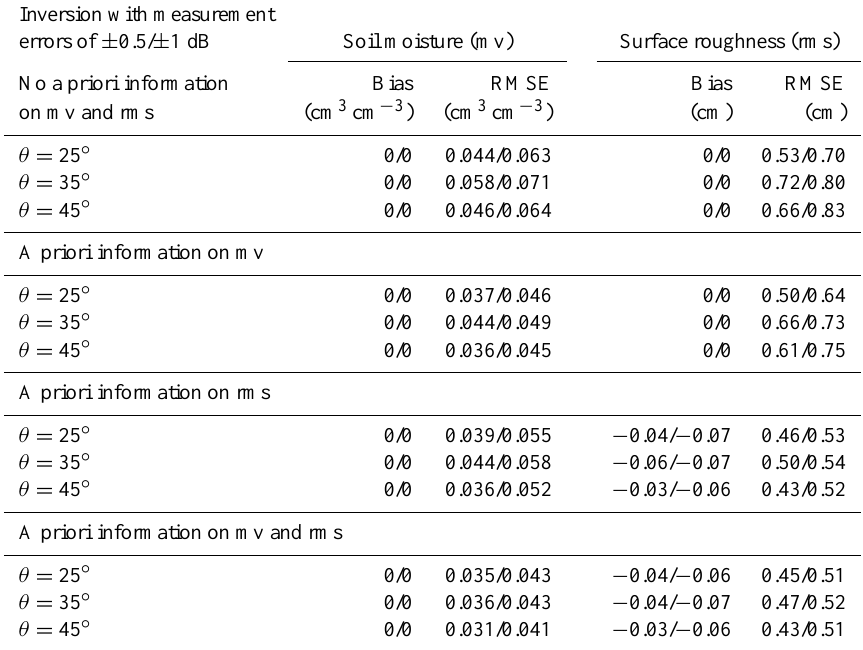
Table 2. Inversion approach results for simulated data with measurement errors of ± 0.5 and ± 1dB. Statistics are given for the estimation of soil moisture (mv) and surface roughness (rms). The format of results is “a/b”, where “a” corresponds to statistics using a noise of ± 0.5dB, and “b” corresponds to statistics using a noise of ±